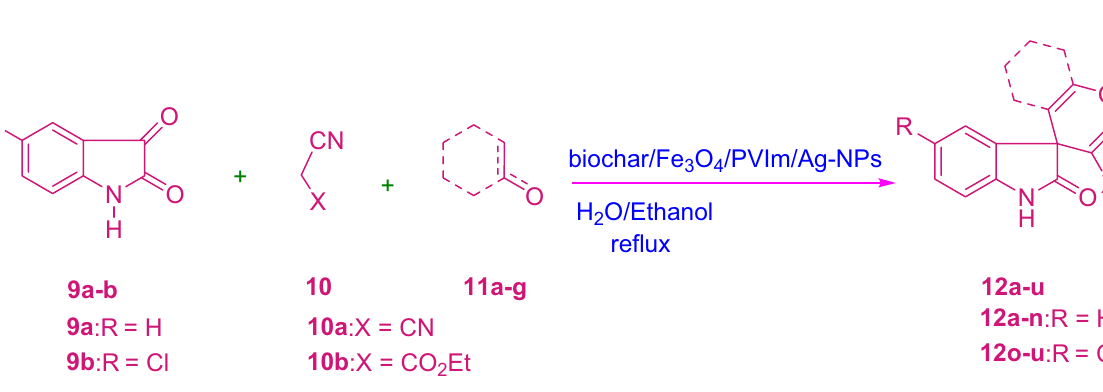
Scheme 3. Synthesis of 12a-u